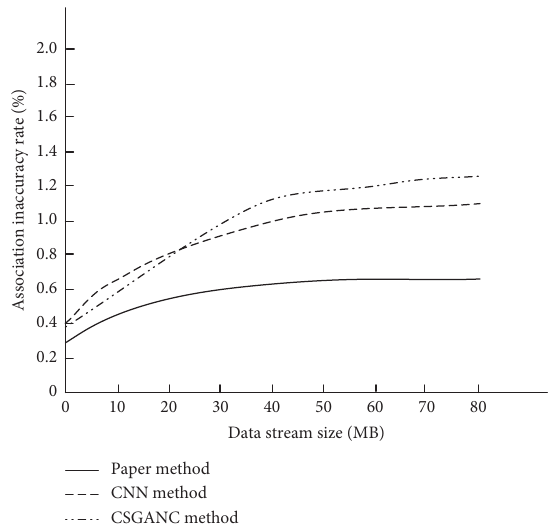
Figure 4: Comparison of correlation misalignment